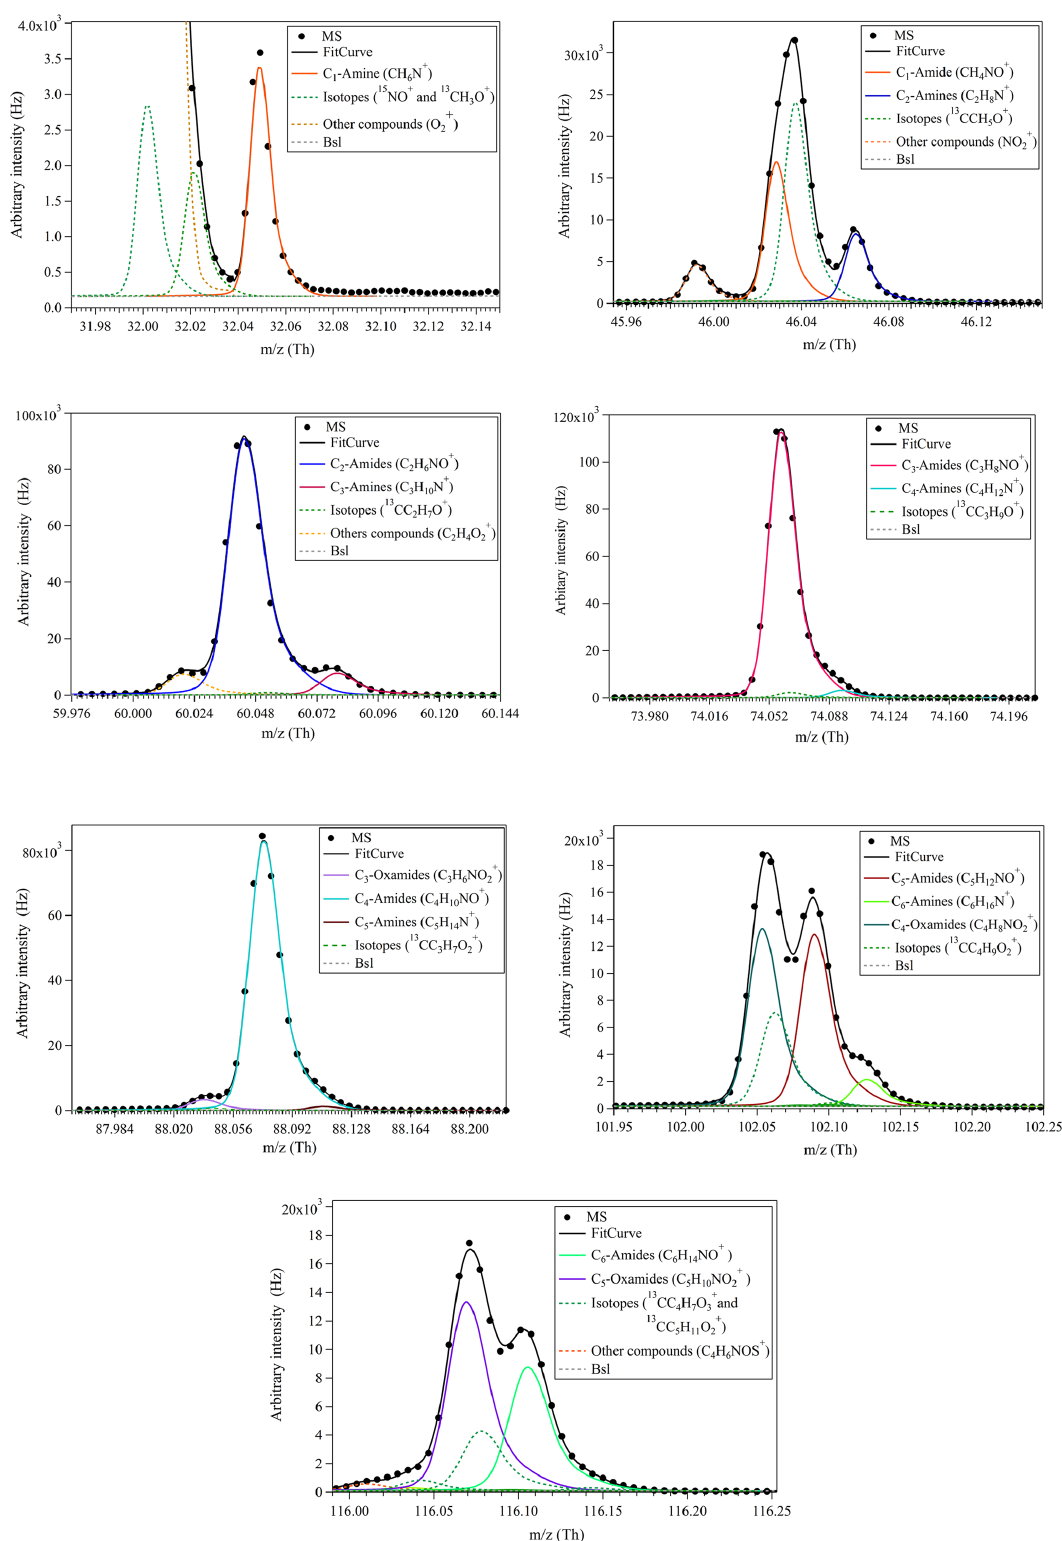
Figure 3. High-resolution single peak fitting (custom shape) for amines and amides. During the peak deconvolution, only peaks whose areas are more than 0.5% of the total will be included in the figure